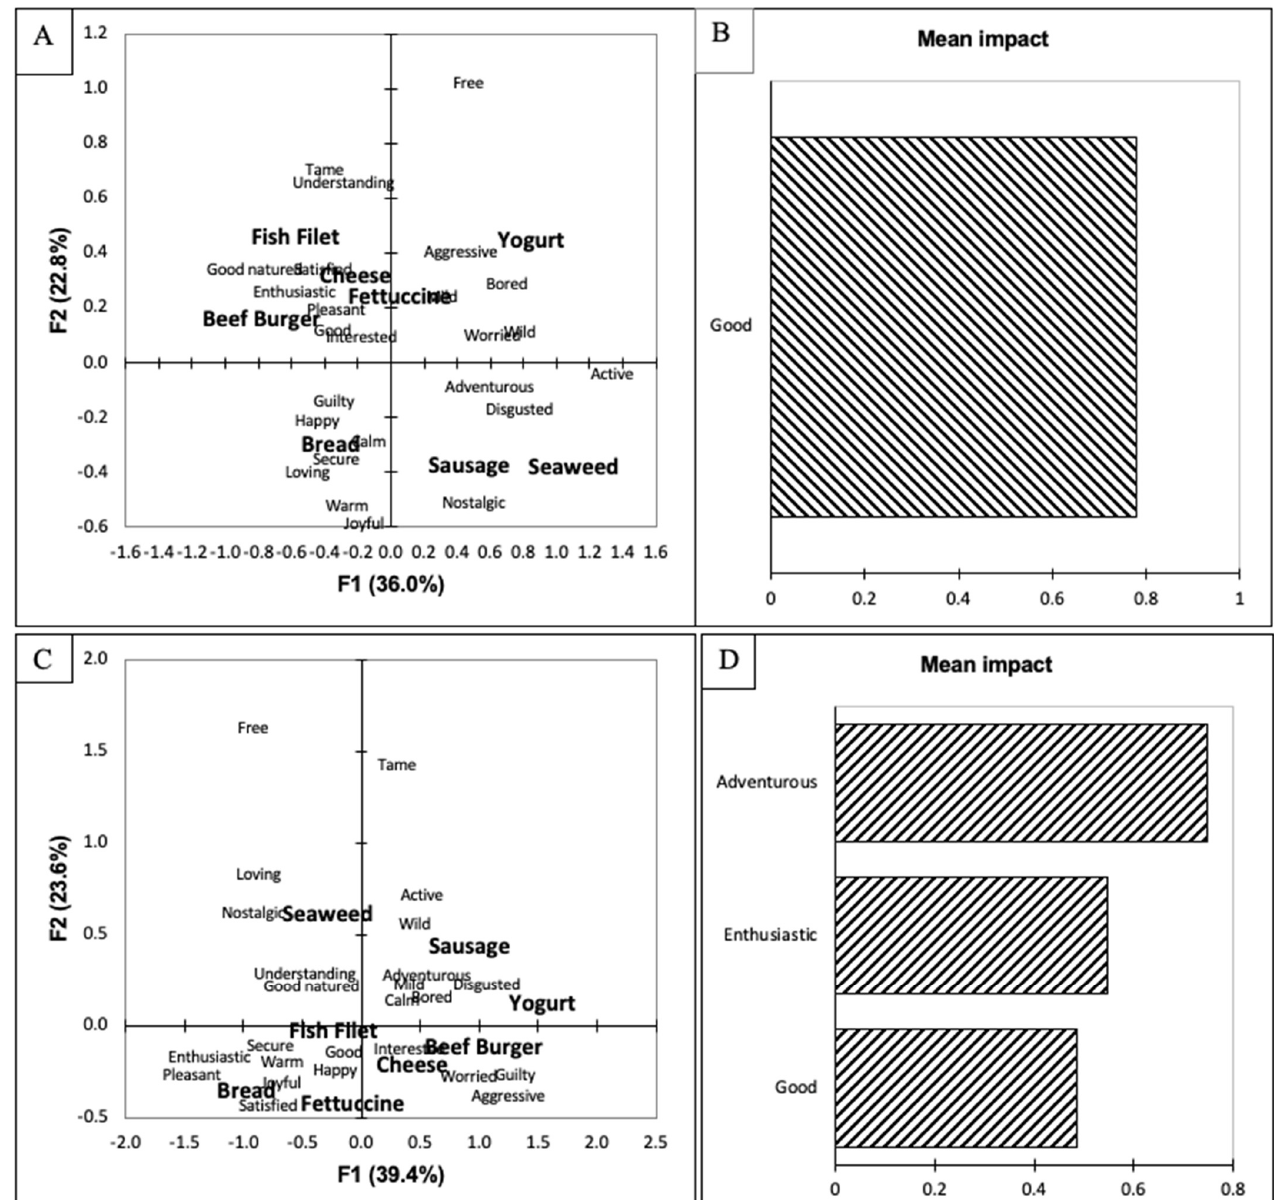
Figure 4. ( A ) Biplot representation of the seaweed-containing food items and emotions terms on the first two dimensions of the correspondence analysis for the population categorized as lower food-related lifestyle (LFRL). ( B ) Penalty lift analysis of the emotional terms and willingness to pay based on the LFRL population’s evaluation of the seaweed-containing food items. ( C ) Biplot representation of the seaweed-containing food items and emotional terms on the first two dimensions of the correspondence analysis for the population categorized as higher food-related lifestyle (HFRL). ( D ) Penalty lift analysis of the emotional terms and willingness to pay based on the HFRL population’s evaluation of the seaweed-containing food items.